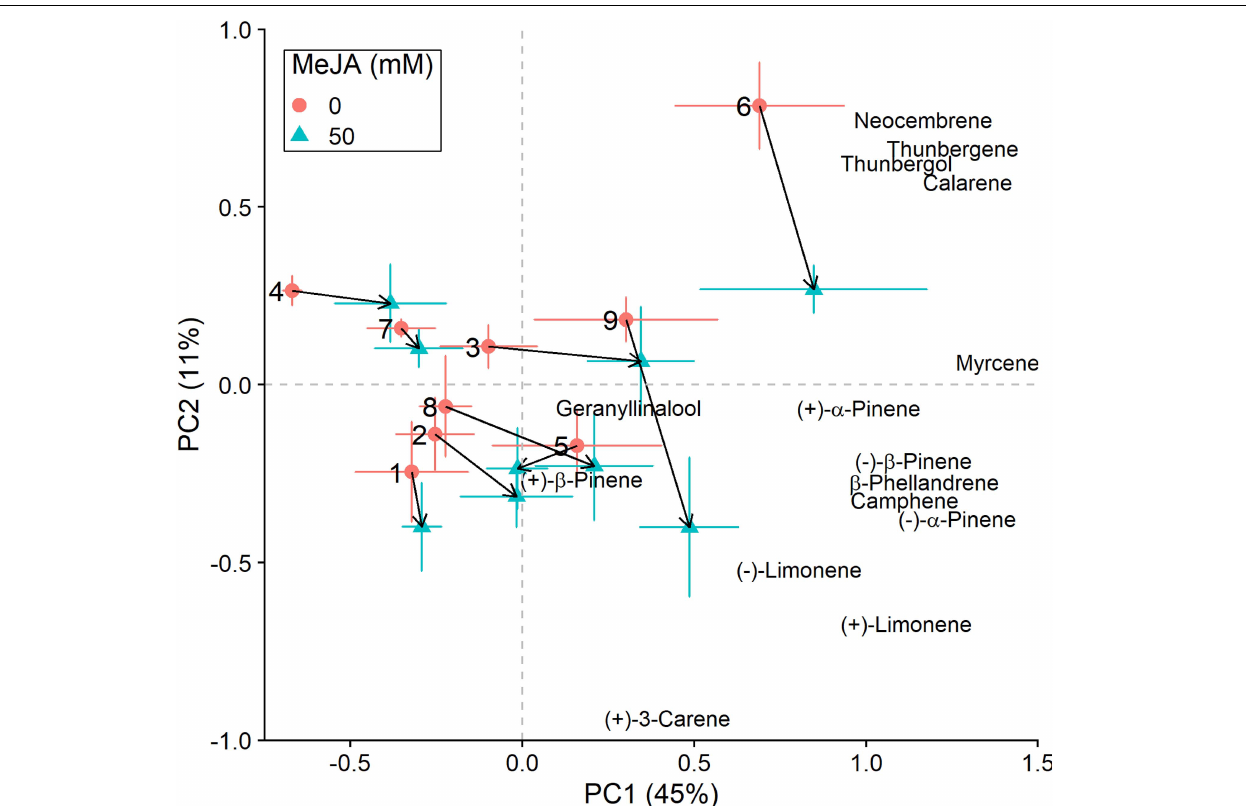
Exposed to fungus